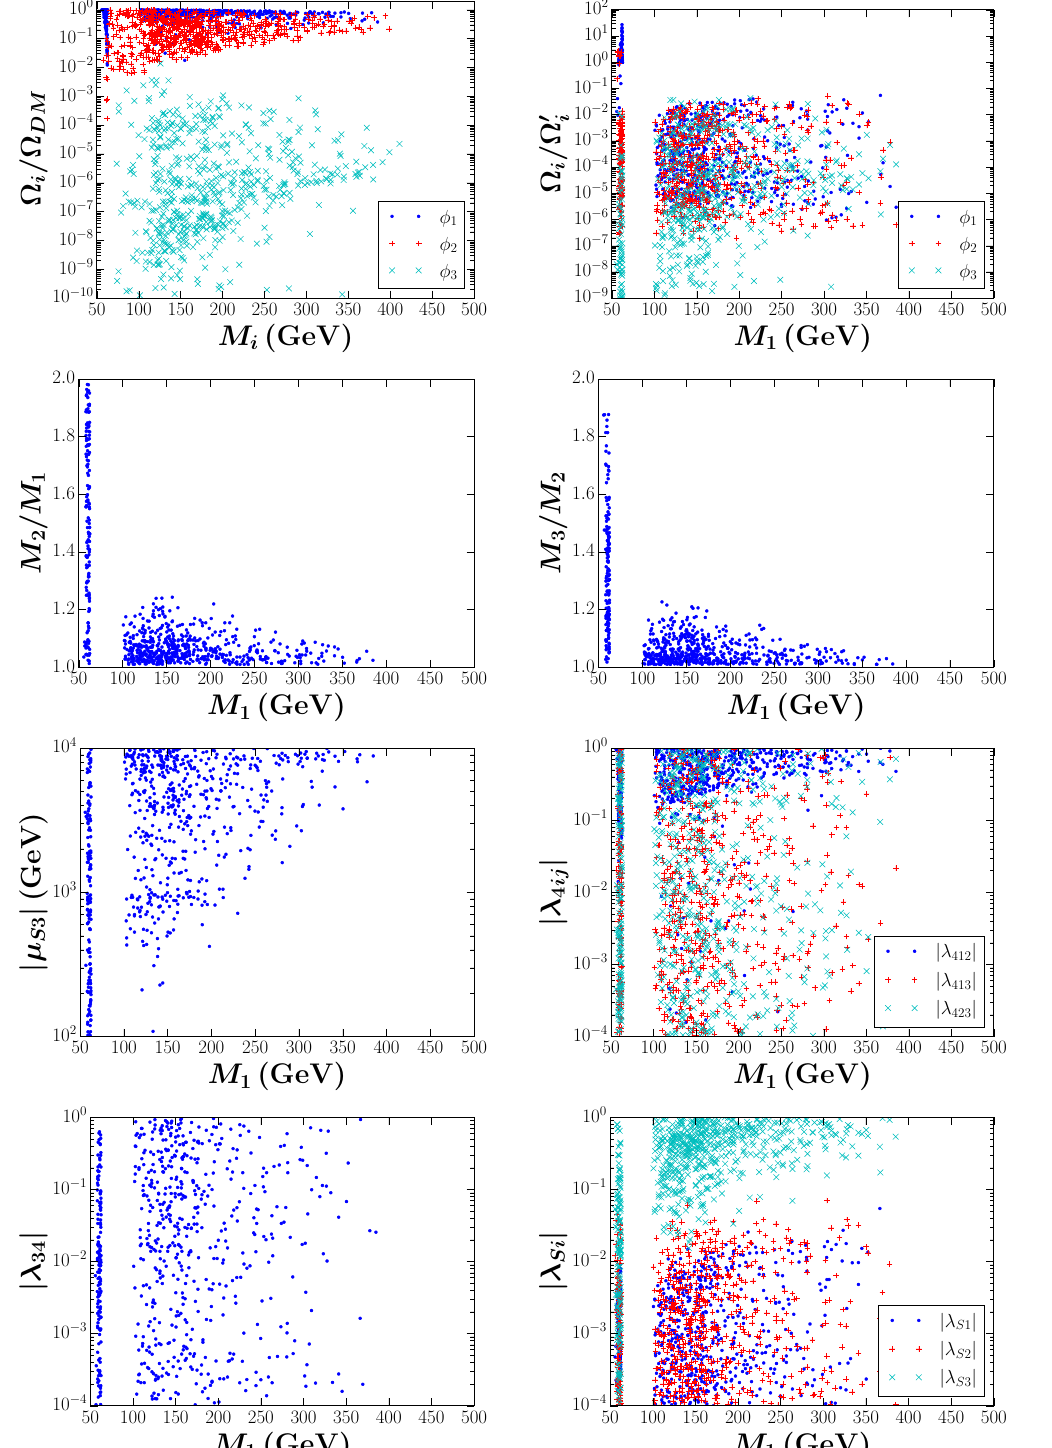
Figure 9 . The viable regions for µ S 3 6 = 0 , λ Si 6 = 0 , λ 4 ij 6 = 0 and λ 34 6 = 0 (scan D). All points shown in these plots are compatible with current